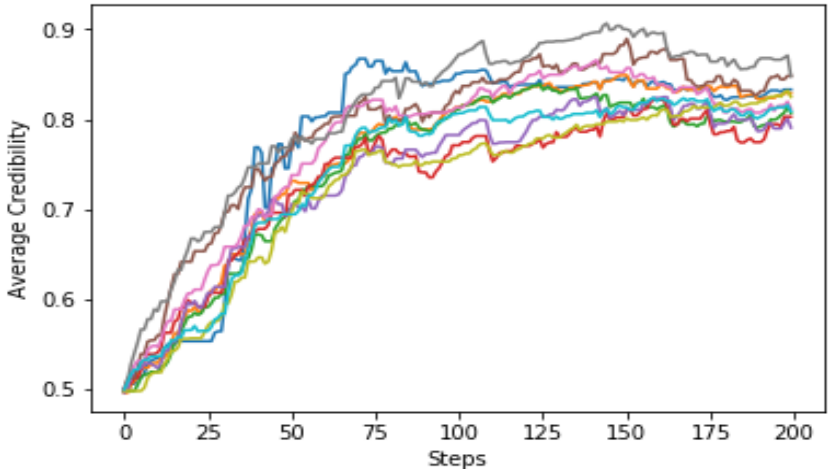
Figure 10. Change in average credibility for each information sharing agent when one agent changes its performance; the change process is as defined in [29].